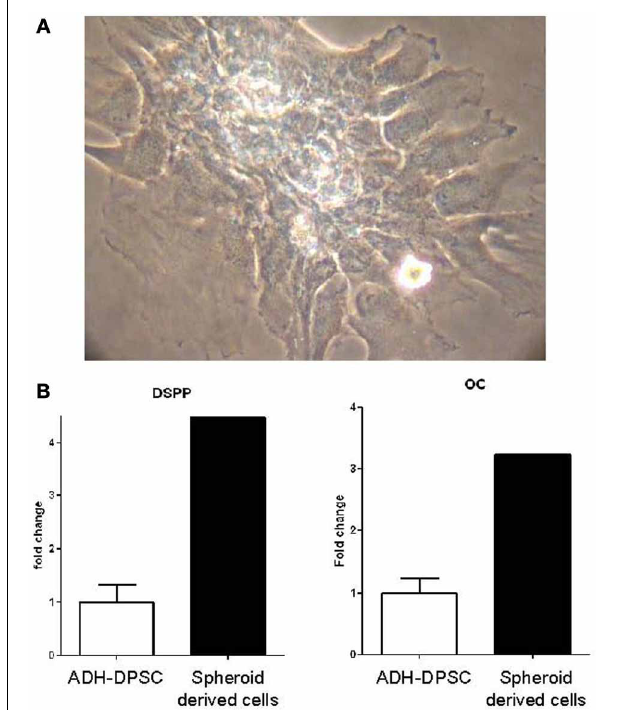
FIGURE 6 | Odontoblastic differentiation of the spheroid clusters. (A) Odontoblast-like morphology of adherent cells that migrated out of spheroid structures after 48h in culture. (B) qPCR analysis of DSPP and osteocalcin gene expressions in spheroid-derived cells in comparison with